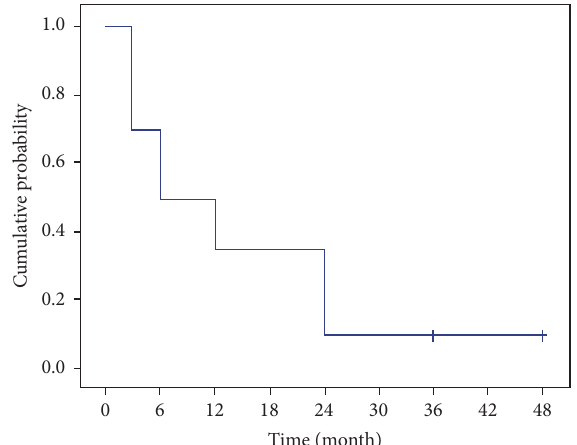
Figure 6: Kaplan-Meier plot of the cumulative probability of “qualified success,” defined as an IOP ≤ 18 mmHg with